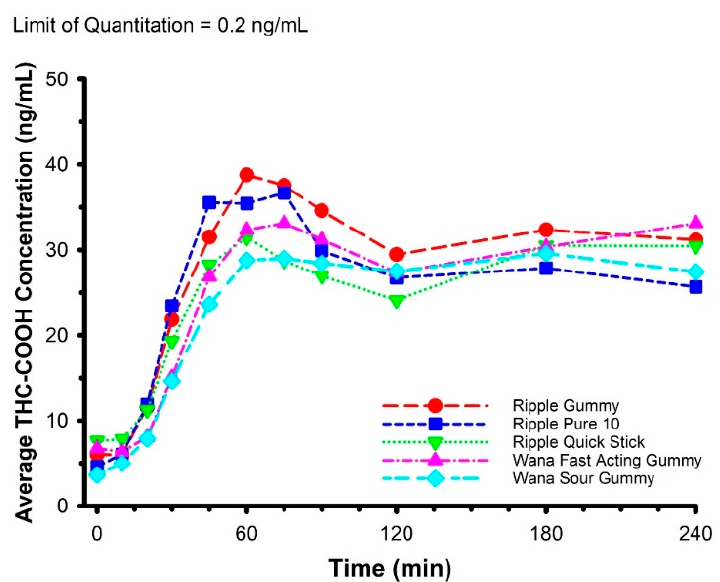
Figure 4. Mean circulating concentrations of THC-COOH following ingestion of commercially available edible marijuana (10 mg of THC). There were no product × time interactions ( p = 0.485). Error bars have been omitted for clarity. Table 3. Pharmacokinetic parameters for THC.